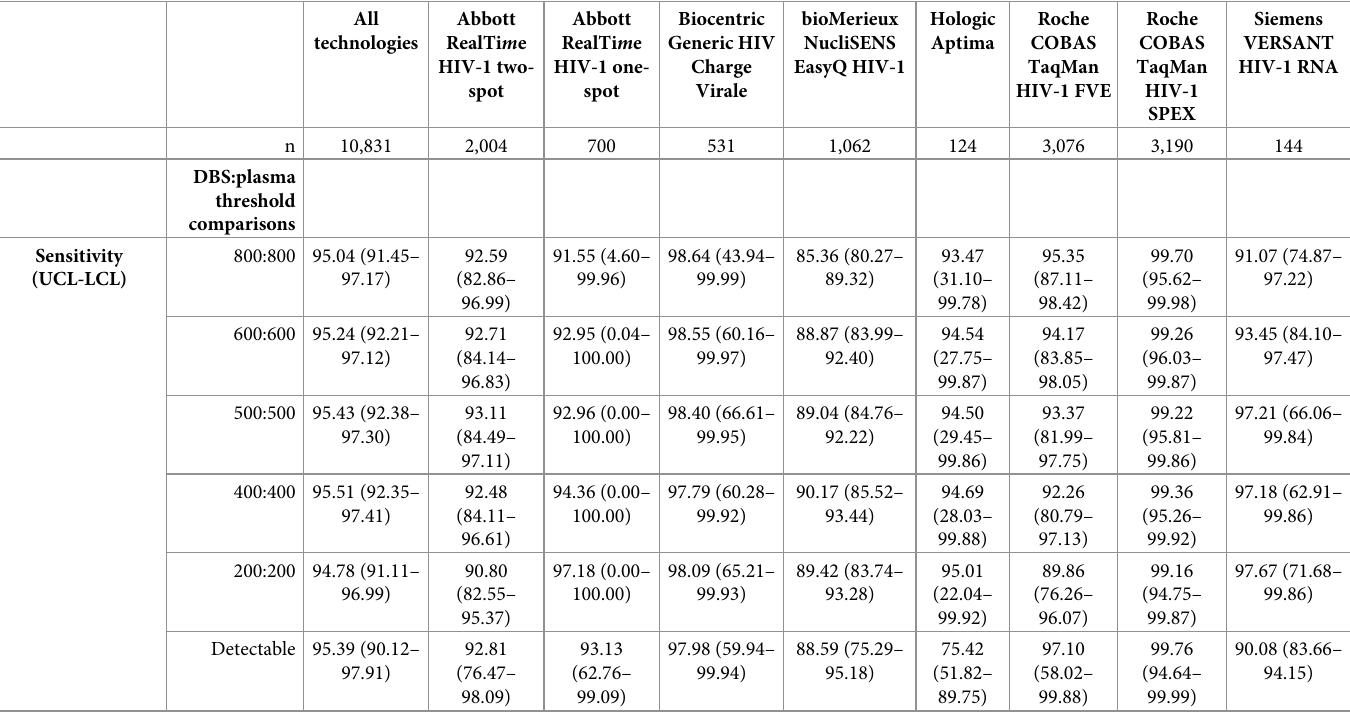
Table 4. Meta-analysis of clinical metrics overall and for each viral load technology and protocol for treatment failure thresholds below 1,000 copies/ml.